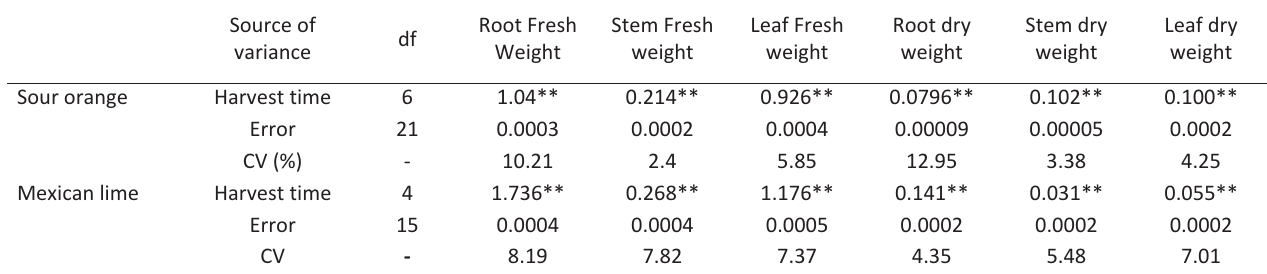
Table 2 ­ Analysis of variance of the effect of harvest time on growth characteristics of sour orange and Mexican lime seedlings in vitro